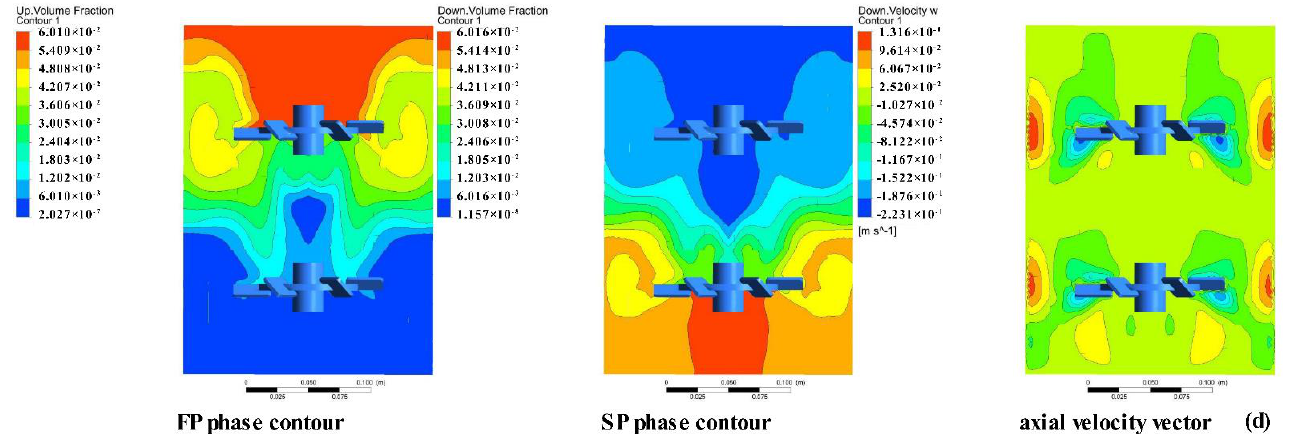
Figure 3. Solid distribution and axial velocity vector for blades (A = 0.6 D, B = 0.3 HL, C = 0.2 D): ( a ) PBT, ( b ) PBD, ( c ) BT, and ( d ) HBT on Y = 0 surface.